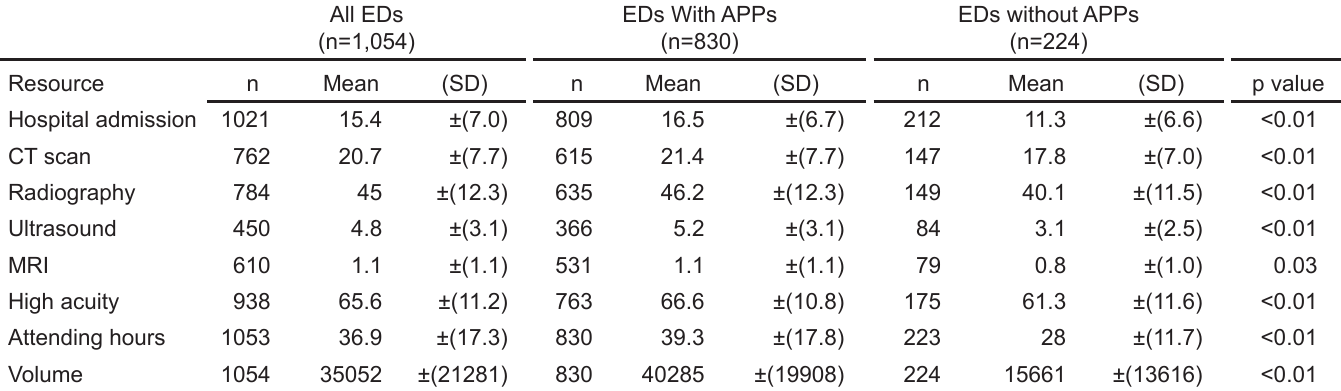
Table 1. Descriptive statistics of emergency departments (ED) by advanced practice provider (APP) status (per 100 patient visits), EDBA 2012‒2016.